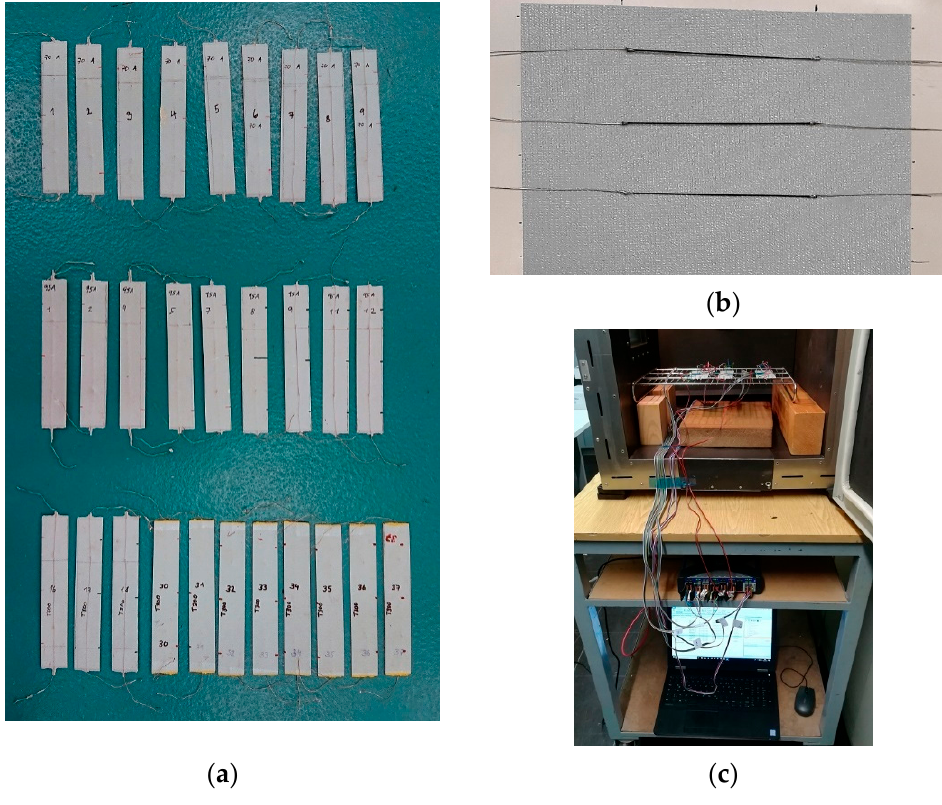
Figure 1. ( a ) Specimens after mechanical loading; ( b ) CFSs type 70A during implementation in the composite lay-up; ( c ) Specimens during temperature loading.